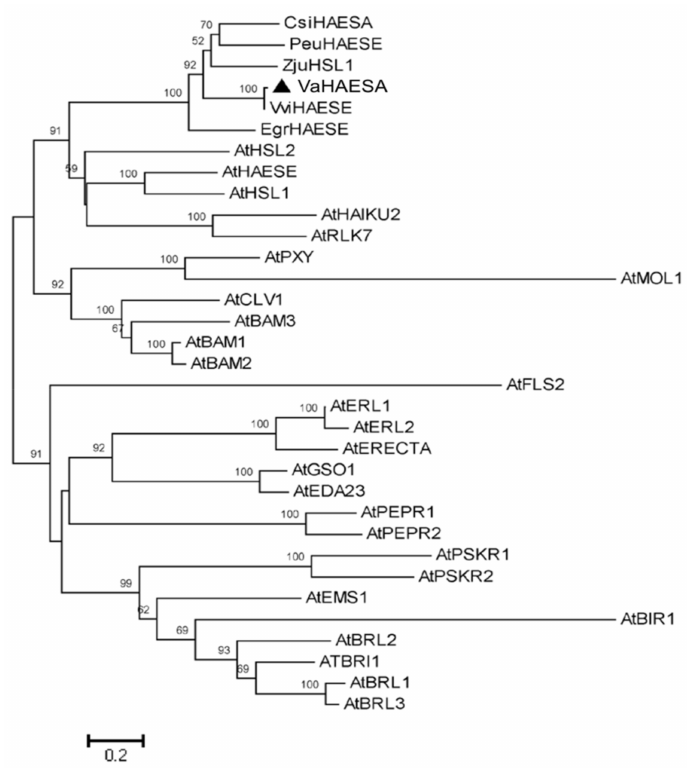
Figure 4. Phylogenetic tree of LRR-RLKs. Vitis amurensis HAESA ( VaHAESA ) is indicated by the filled triangle.